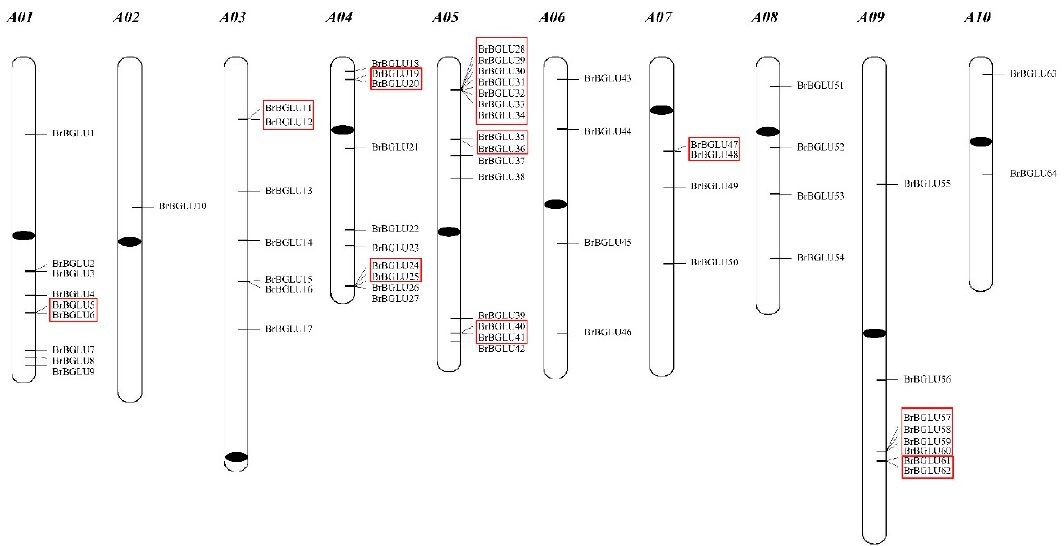
Figure 1. Chromosomal distribution of the 64 BrBGLU genes identified in this study. The chromosome number is indicated above each chromosome. Ten clusters of BrBGLUs are indicated in red boxes. Black ovals on each chromosome represent the centromeric regions.